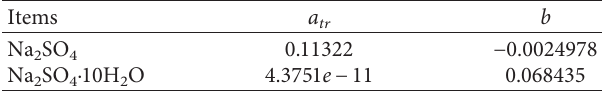
Table 6: Value of the fitted data.